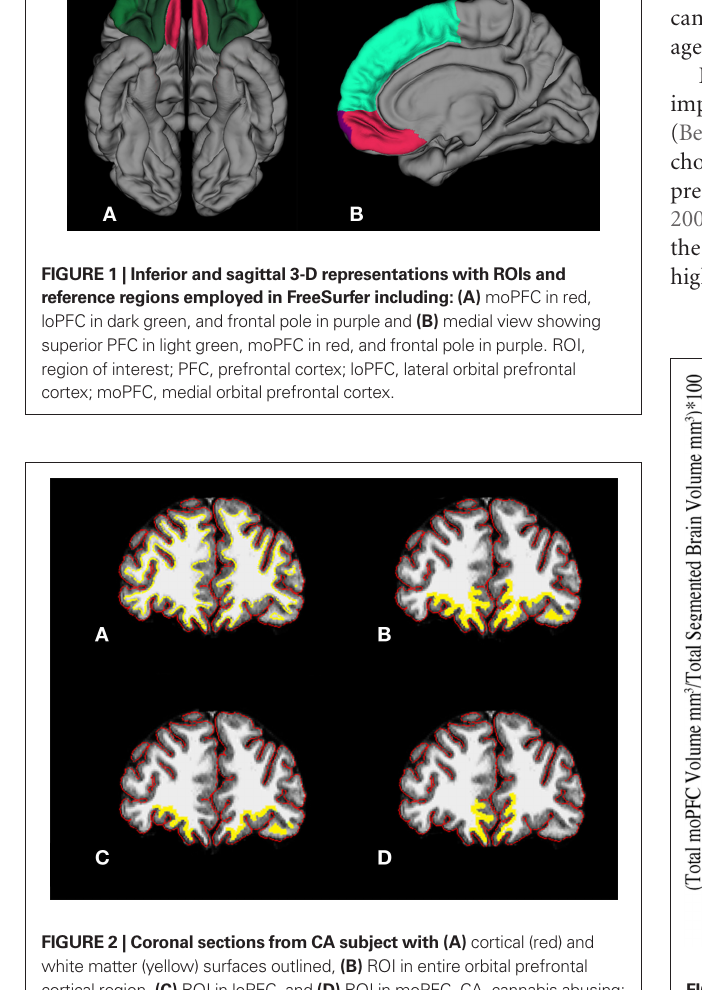
FiguRE 3 | Correlation between total moPFC volume and age of first use in adolescent cannabis users, r (18) = 0.49, p = 0.03. Two scores overlap in scatter plot, ( N = 18). moPFC, medial orbital prefrontal